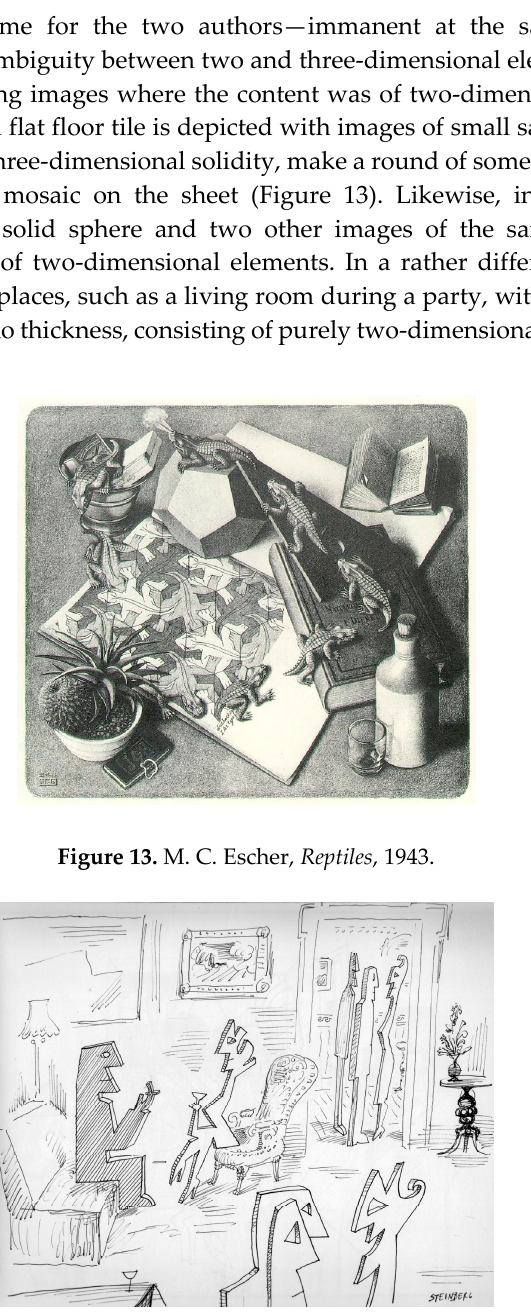
Figure 14. S. Steinberg, from The Discovery of America ,